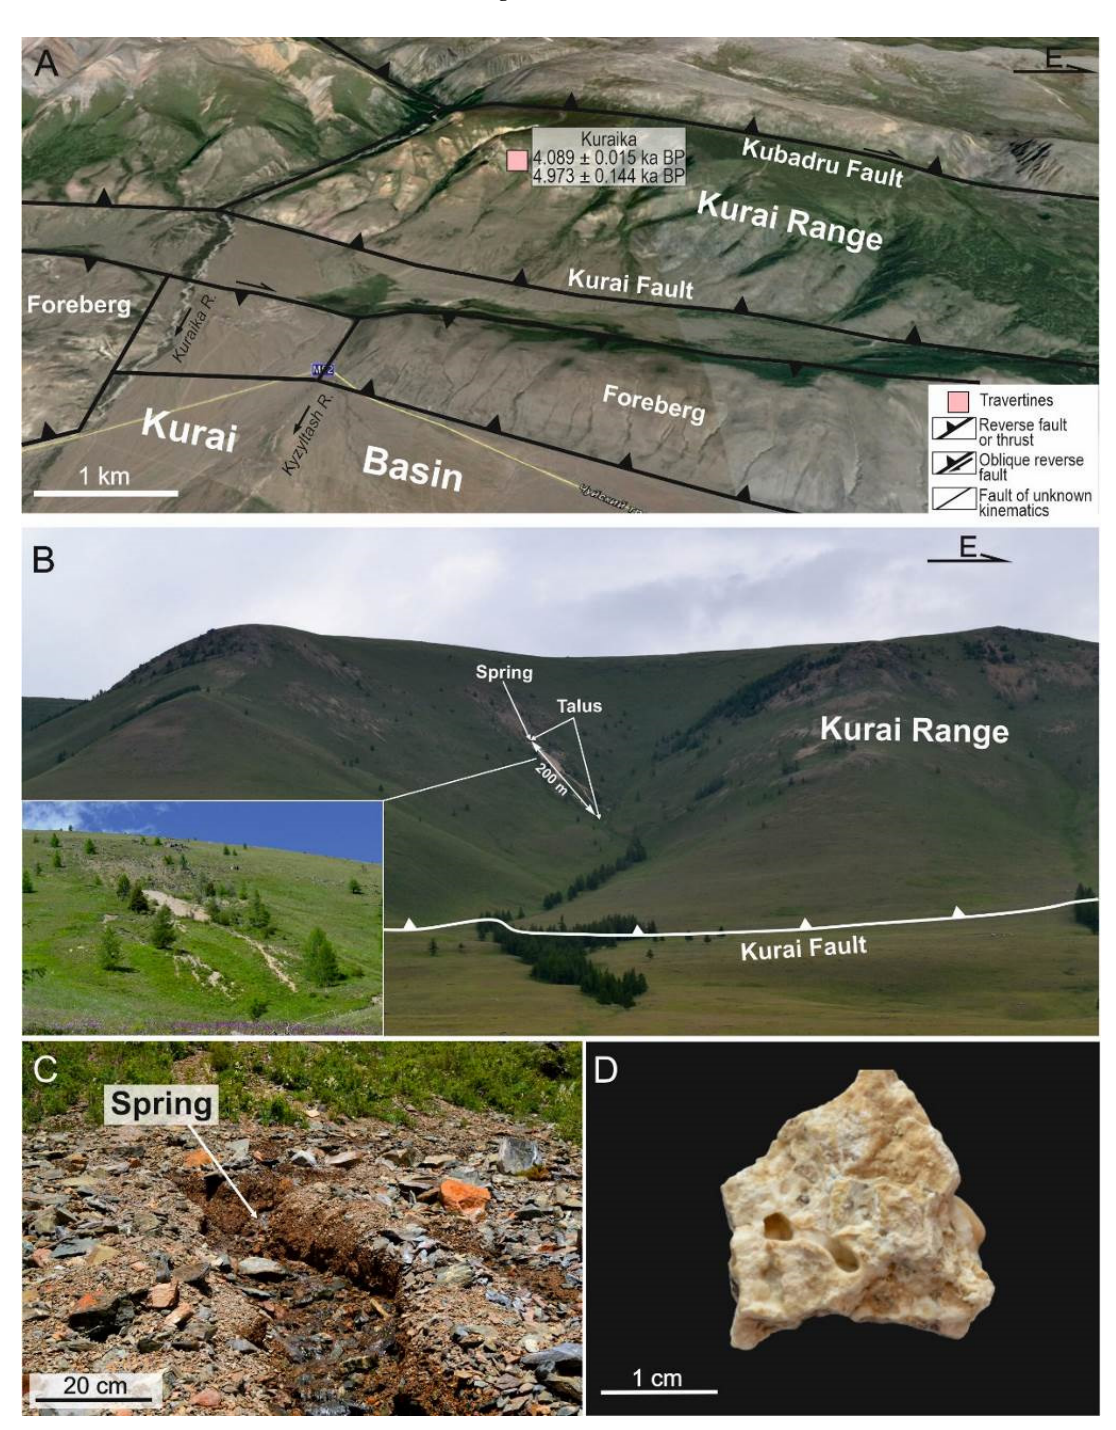
Figure 5. Location and morphology of the Kuraika travertines. ( A ) Structure of the Kurai Fault Zone and northern part of the Kurai Basin, showing the location and U-Th dates of the Kuraika travertines (50.28034° N, 88.00408° E). ( B , C ) Emerging spring and scree slope, composed of travertine on the southern slope of the Kurai Range. ( D ) Travertine fragment.